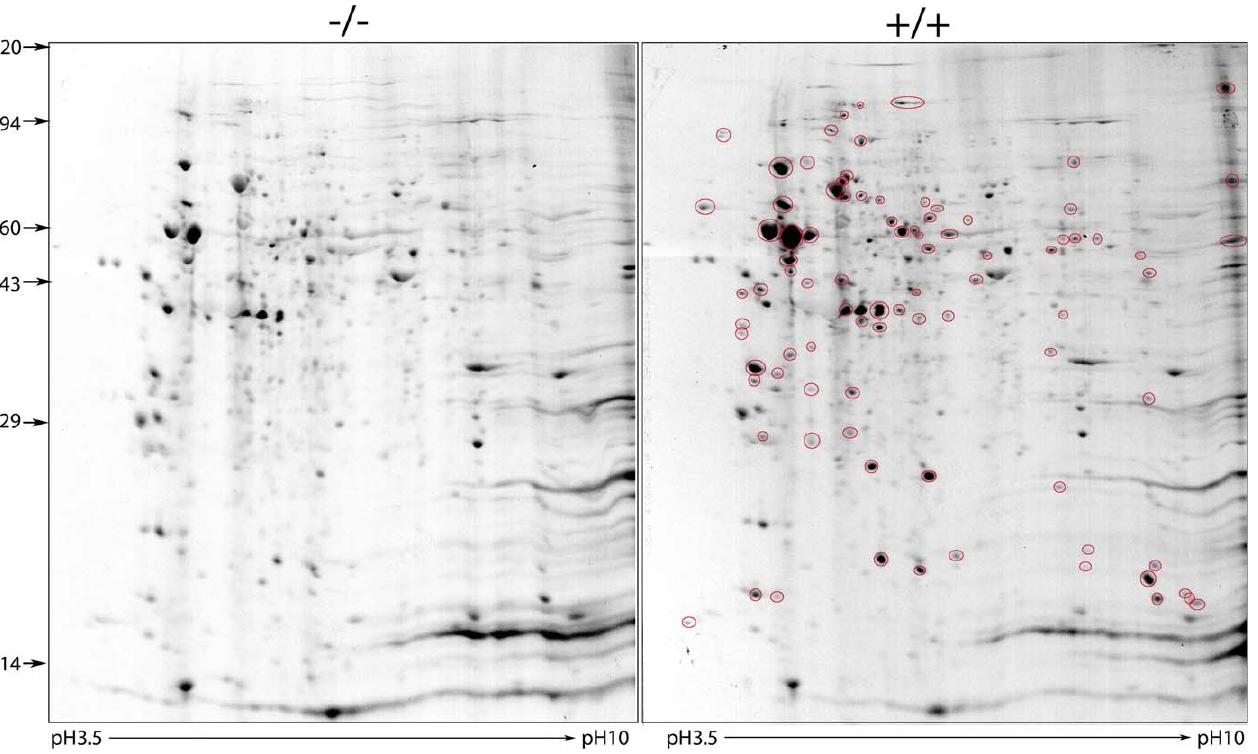
Figure 2. Posttranslational Incorporation of Arg into Proteins in Cultured Cells Autoradiographs of wild-type ( þ / þ ) and Ate1 (cid:2) / (cid:2) ( (cid:2) / (cid:2) ) whole cell extracts treated with cycloheximide in medium containing 14 C-Arg, fractionated on 2D gels. Spots circled in red in the wild-type gel show increase in Arg incorporation above that in the Ate1 (cid:2) / (cid:2) cells, suggesting that Arg in these spots is incorporated posttranslationally. Proteins identified in the most abundant of the up-regulated spots are listed in Table S3.